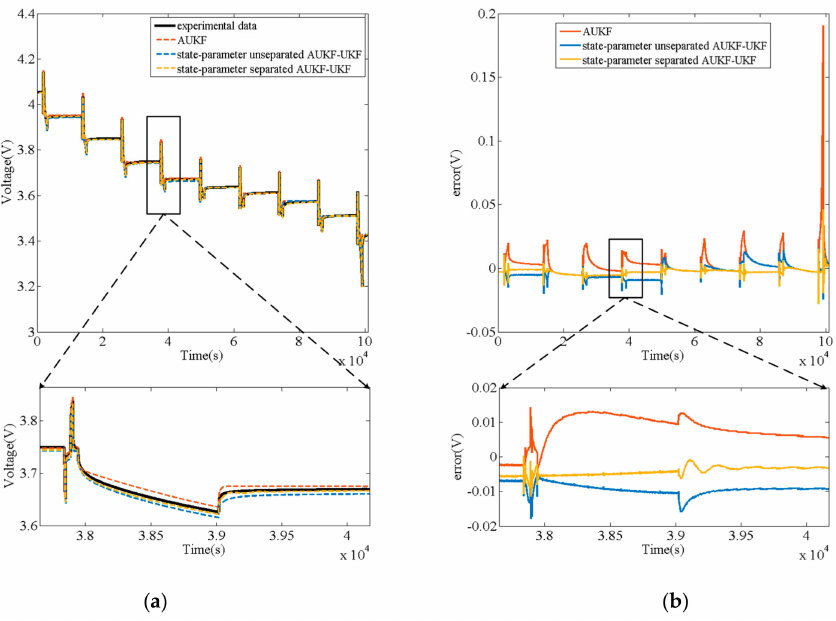
Figure 14. ( a ) The comparison of the open-loop model output between three algorithms under HPPC test; ( b ) The comparison of the open-loop model output error between three algorithms under HPPC test.